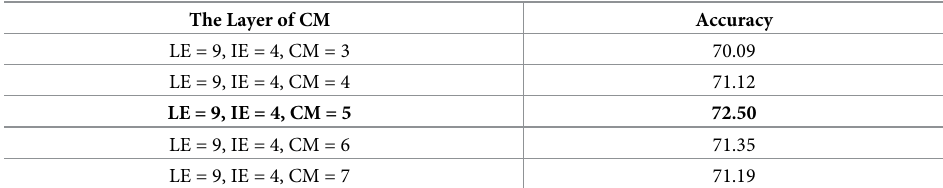
Table 3. Effect of the number of CM layers on model accuracy.